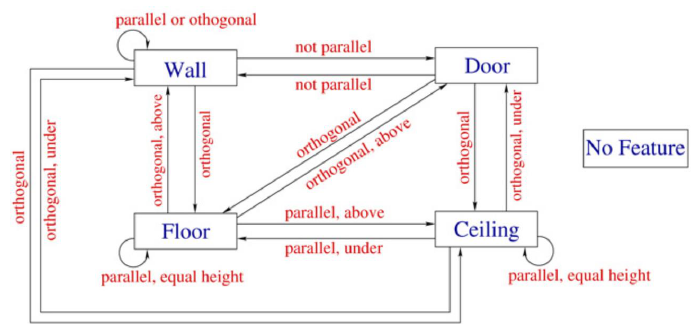
Figure 12. Semantic net [63].